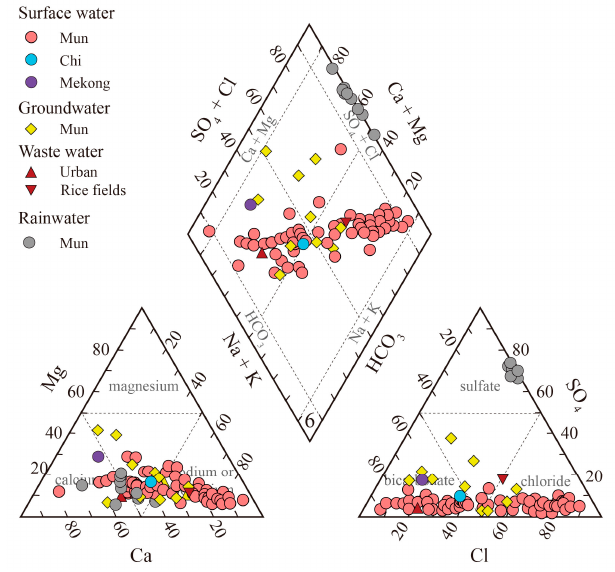
Figure 3. Piper diagram showing cations and anions compositions. The data of the rainwater came from Data report on the acid deposition in the East Asian Region. 2016. Available online: // http://www.eanet.asia. http: